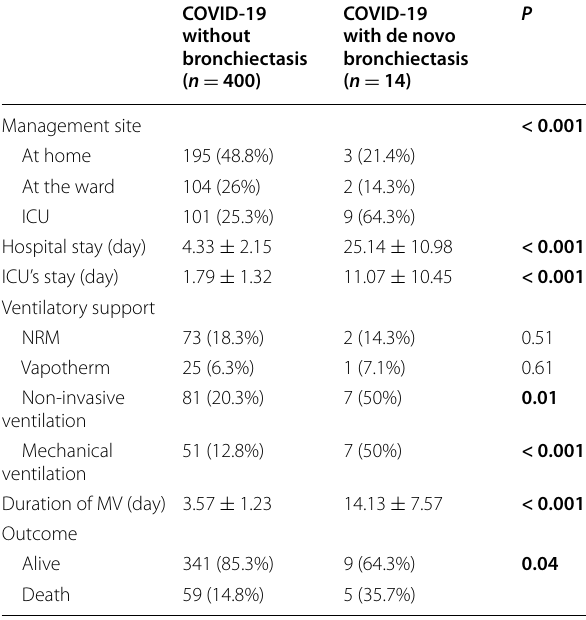
Data expressed as frequency (percentage), mean (SD). P value was significant if < 0.05 ICU intensive care unit, NRM non-rebreathing mask, MV mechanical ventilation, COVID-19 coronavirus disease 2019 Continuous data was compared Mann-Whitney test and all nominal data was compared by chi 2